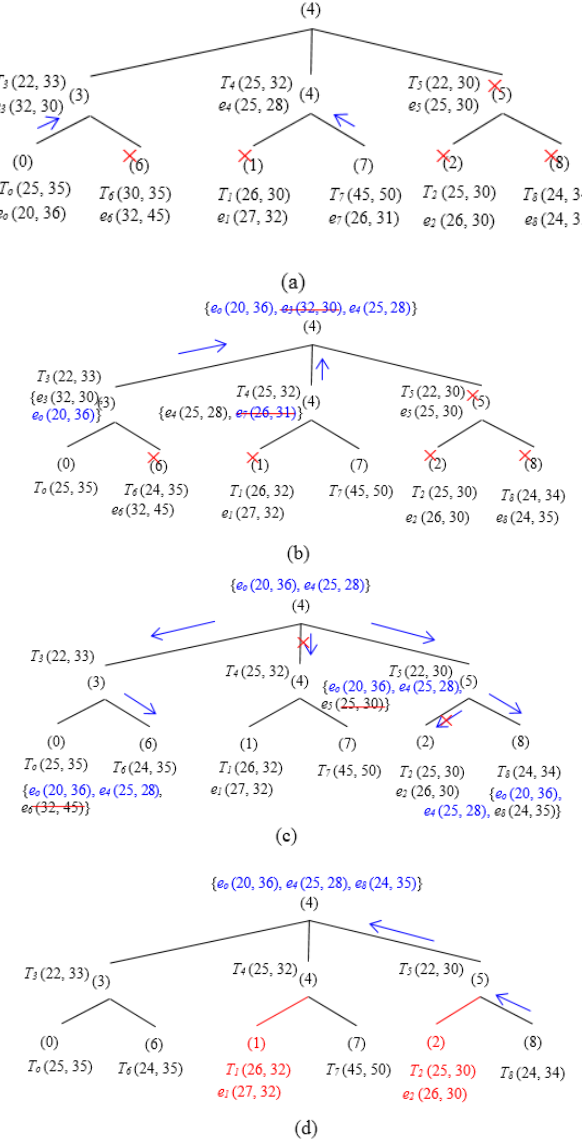
Figure 11. Basic Approach Example (3 × 3 Grids). ( a ) Regular update. ( b ) Skyline set after first phase. ( c ) Triggered query. ( d ) Skyline set after second phase